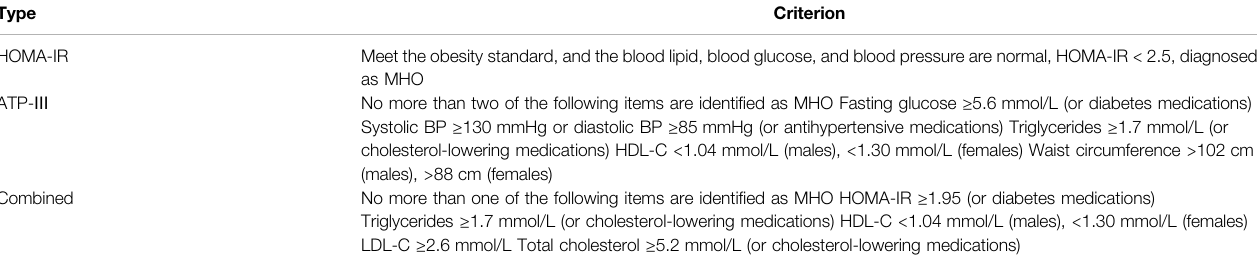
TABLE 1 | De fi nitions of MHO in